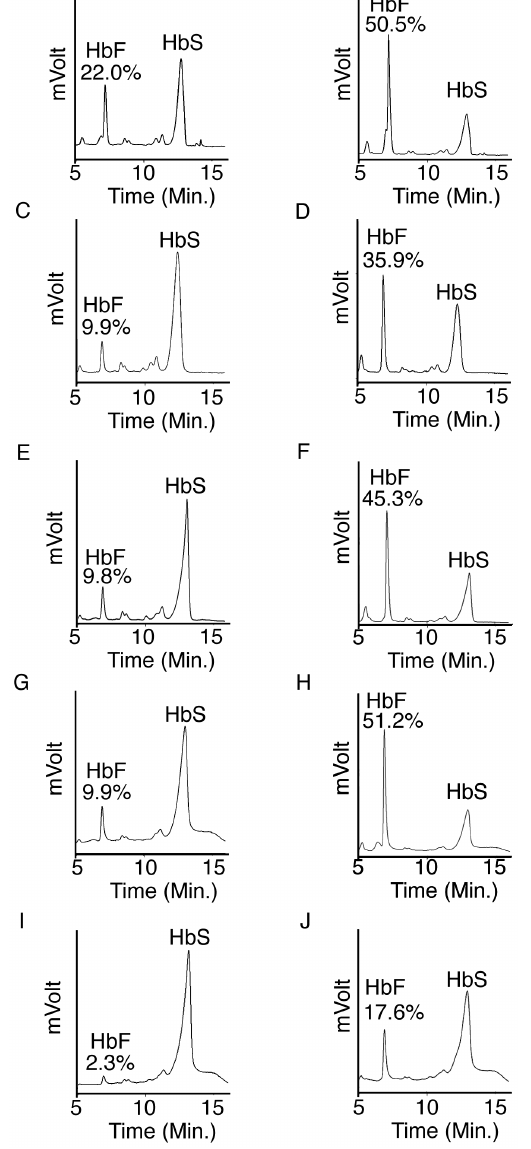
Figure 4. LIN28A regulates fetal hemoglobin levels in cultured human sickle erythroblasts. HPLC analysis of hemoglobin from control and LIN28A -OE samples were performed at culture day 21. Donor 1 (A) Control and (B) LIN28A -OE, Donor 2 (C) Control and (D) LIN28A -OE, Donor 3 (E) Control and (F) LIN28A -OE, Donor 4 (G) Control and (H) LIN28A -OE and Donor 5 (I) Control and (J) LIN28A -OE. HbF and HbS peaks are labeled with the ratio of HbF/HbF + HbS expressed as a percentage above each HbF peak (y-axis, mVolts; x-axis, elution time in minutes).